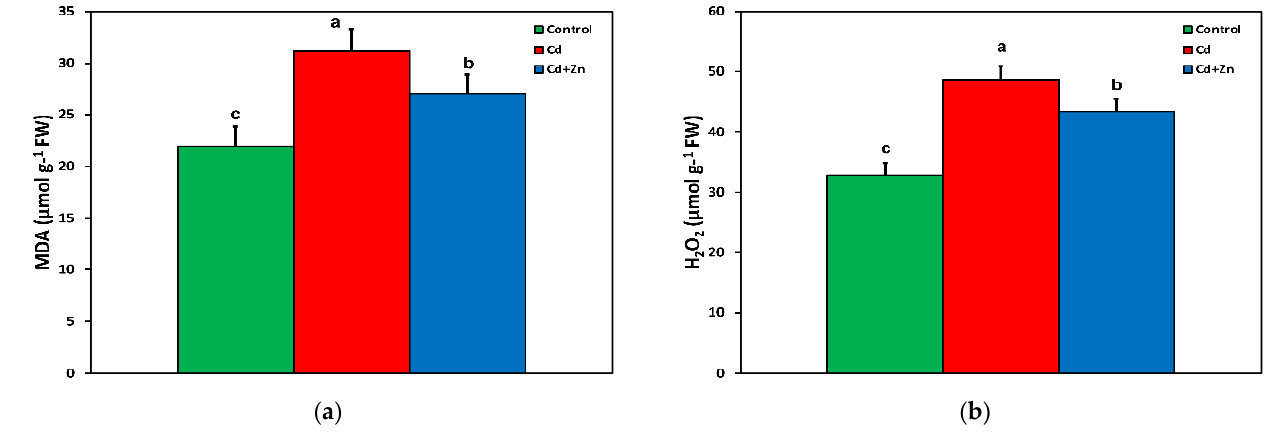
Figure 5. Changes in the level of lipid peroxidation, assessed by the accumulation of malondialdehyde (MDA) ( a ), and the generation of hydrogen peroxide (H 2 O 2 ) ( b ), in the leaves of Salvia sclarea control (nutrient solution), Cd 2+ (nutrient solution +100 μ M Cd 2+ ), and Cd 2+ + Zn 2+ (nutrient solution +100 μ M Cd 2+ + 900 μ M Zn 2+ ). Error bars are standard deviations ( n = 5). Columns with different lowercase letters are statistically different ( p < 0.05).